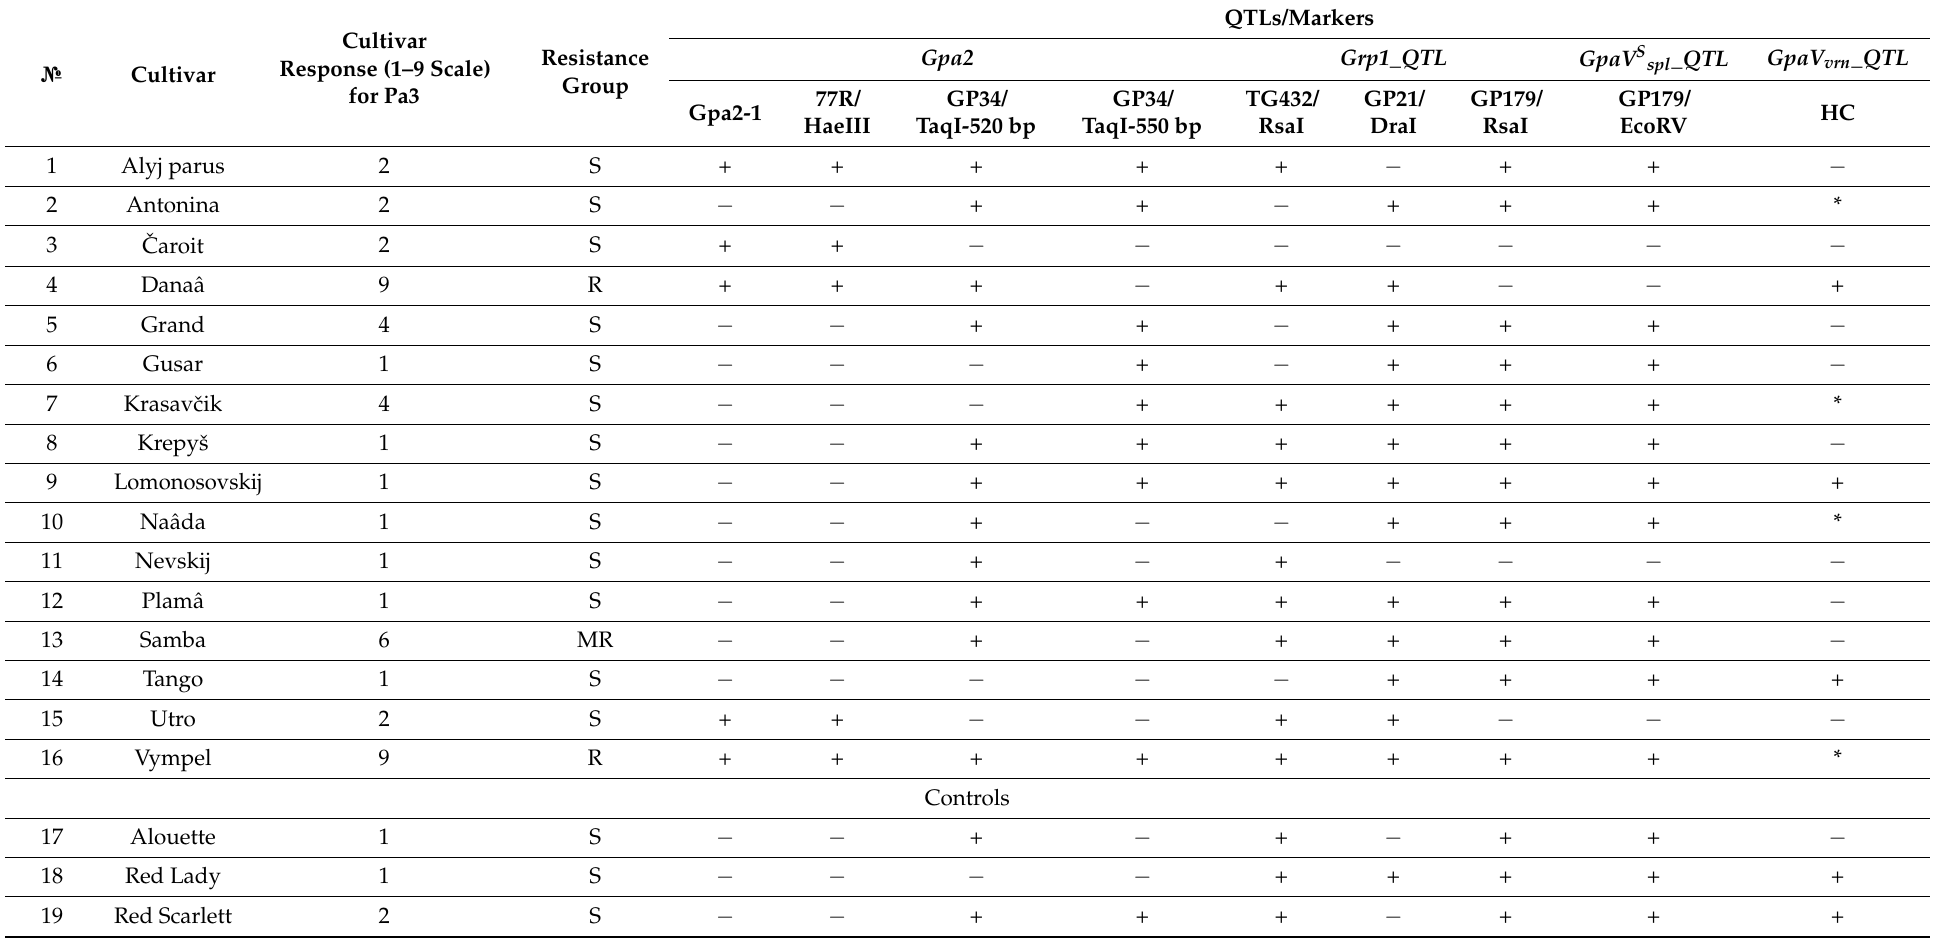
Table 6. Molecular marker analysis of potato cultivars with DNA markers associated with QTLs conferring resistance to G. pallida pathotype Pa3. “+”—diagnostic fragments present, “ − ”—diagnostic fragments absent. Resistance group: R—resistant, MR—moderately resistant, S—susceptible.